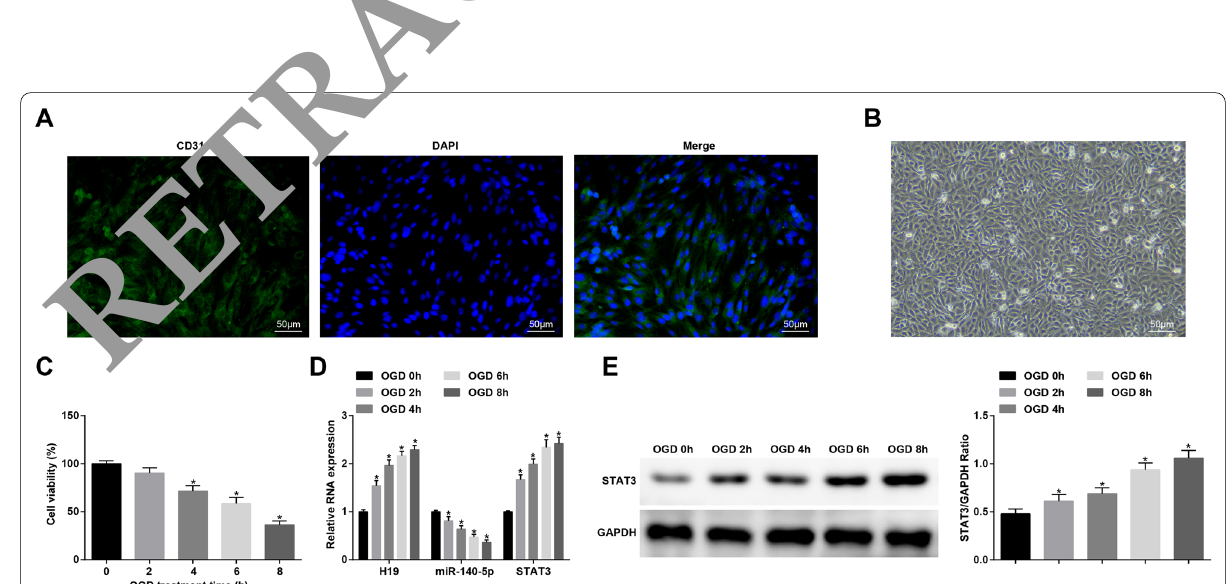
Fig. 1 Identification and morphological observation of BMECs; H19 and STAT3 are overexpressed while miR-140-5p is down-regulated in OGD-induced BMECs. A CD31-positive cells detected by immunofluorescence staining; B Observation of morphology of BMECs; C Cell viability after OGD treatment detected by MTT assay; D , E H19, miR-140-5p and STAT3 expression at 0, 2, 4, 6, and 8 h of OGD treatment detected by RT-qPCR and western blot assay; N 3. The data were expressed as the mean standard = ±